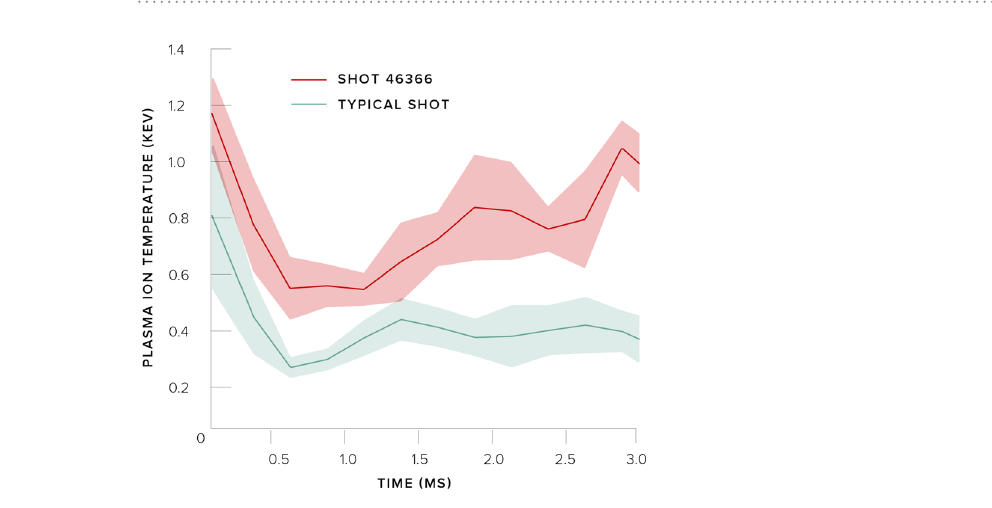
Figure 2. Plasma ion temperature climbs rapidly after 1 ms and reaches values of ∼ 1 keV by 3 ms into the discharge on Shot 46366. Typical temperatures are lower and show little to no rise in time.